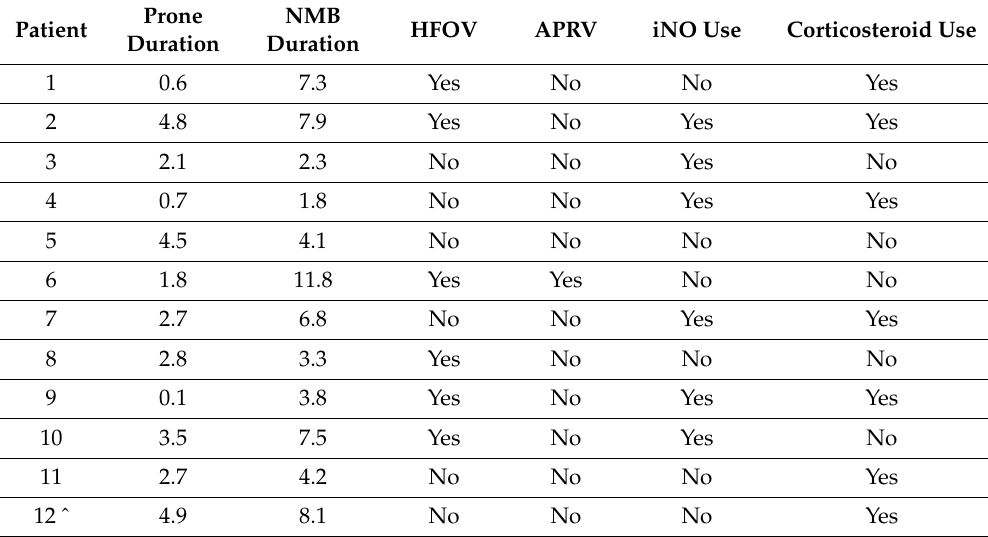
Figure 2. Oxygenation Index Trends After Starting Rotational Bed Therapy. Figure Legend: Comparison of oxygenation index trends prior to prone positioning and then after at 6 h intervals for the first 48 h. After prone positioning oxygenation indices improved over time. Oxygenation indices reported as medians, IQR, and ranges for each period examined. * = p -value < 0.05, ** = p -value < 0.01, *** = p -value < 0.001. Table 2. Ancillary Therapy utilized for each subject in case